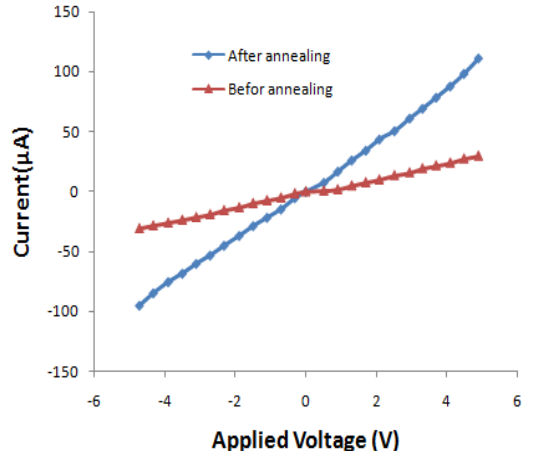
Fig.4: The I-V characteristic of the Pt/ZnO/Pt before and after annealing at 450 o C for 4h.